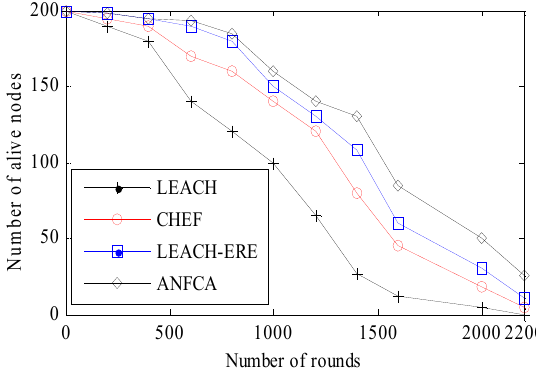
Figure 6. Number of functioning nodes over the rounds.